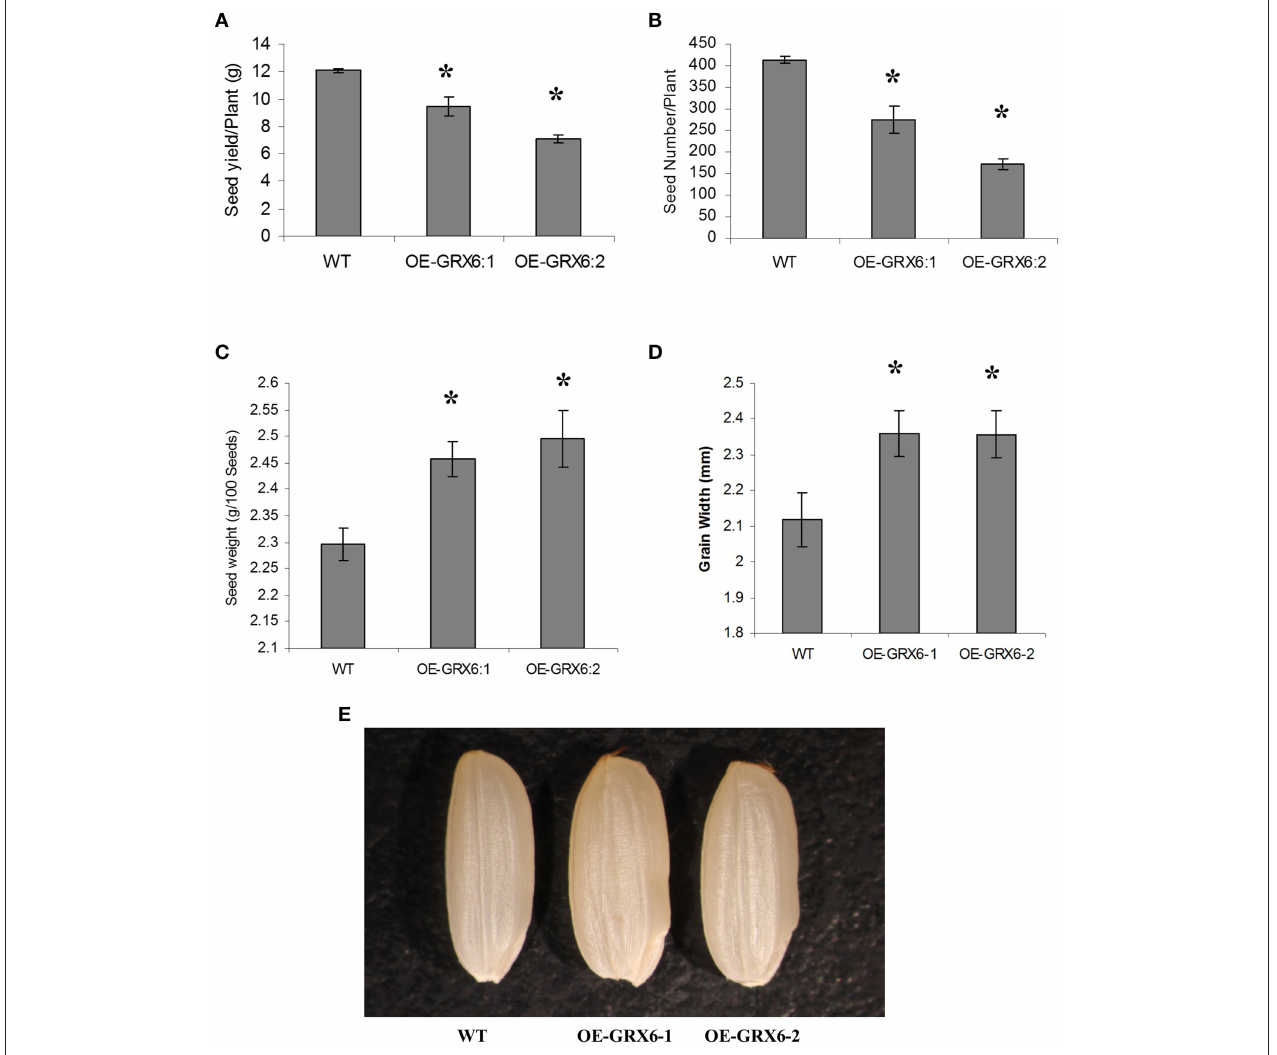
FIGURE 3 | Rice grains yield components as affected by the overexpression of the OsGRX6. Total seed weight per plant (A) , seeds number (B) , Data are means ± SD of 24 plants, individual seed weight (C) , Data are means ± SD of six replicates, and grain width (D,E) , Data are means ± SD of six replicates of 20 grains. Asterisks indicate significant differences at P ≤